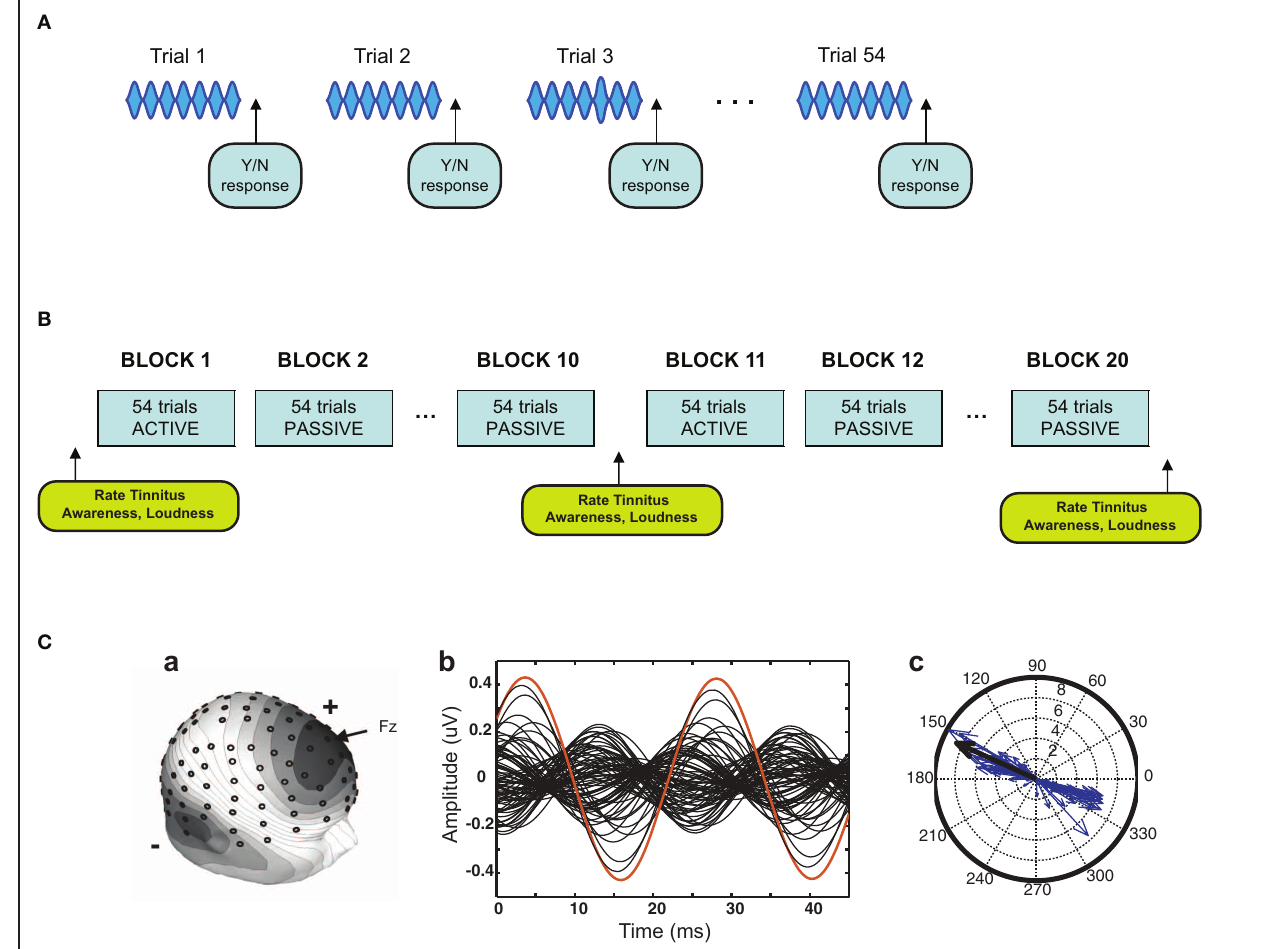
FIGURE 1 | Experimental design. (A) Stimulus procedure. The stimulus was a 5kHz 40-Hz AM pure tone of 976ms duration. Approximately 2/3 of the stimuli contained a single 40Hz AM pulse of variable increased amplitude (target) that occurred randomly in an interval commencing 415ms after sound onset. Participants pressed one of two mouse buttons after each trial to indicate whether a target had or had not occurred. Four trials are depicted here in simplified form (each trial contained 40 AM pulses), with a target illustrated on the third trial. (B) Training procedure. Sessions consisted of 20 blocks of trials each block containing 54 trials. Tinnitus awareness and loudness were probed within sessions as shown. On days on which the EEG was recorded (sessions 1, 4, and 7) blocks alternated between active and